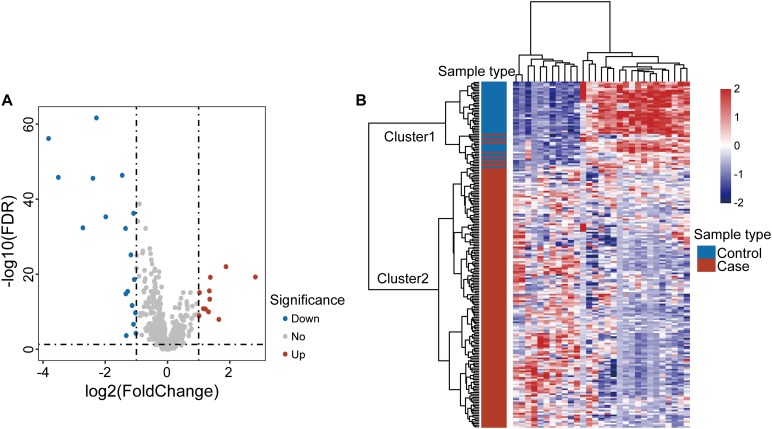
Analysis of differentially expressed genes in oral squamous cell carcinoma. (A) Volcano plot displaying differential expressed lncRNAs between OSCC samples and control samples. (B) Unsupervised clustering of all samples based on the expression pattern of 29 differentially expressed lncRNAs in the discovery dataset.